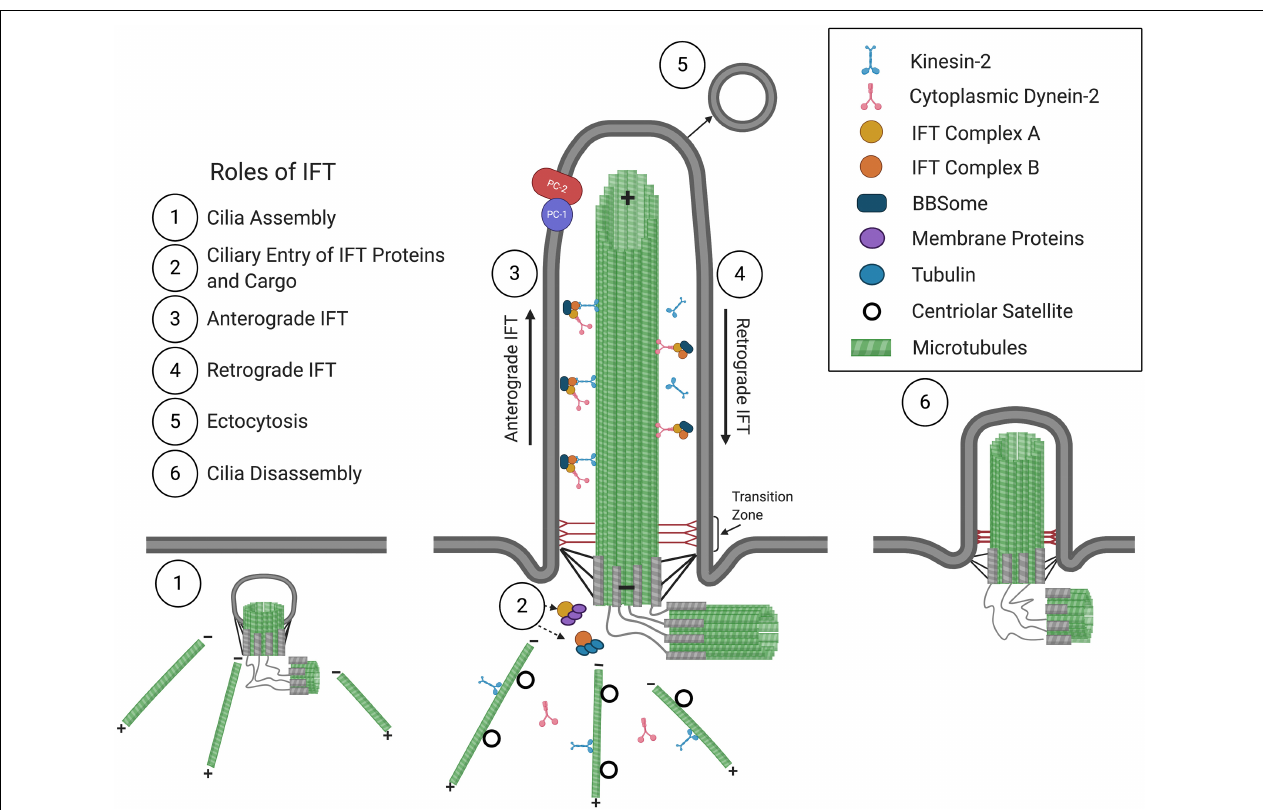
FIGURE 1 | The primary cilium and roles of IFT in cilium assembly/disassembly. Consisting of a 9 + 0 arrangement of a microtubular axoneme ensheathed by a specialized ciliary membrane, the primary cilium assembles initially within the cytoplasm at the modified centriole (1), which becomes the basal body that forms the base of the primary cilium at the plasma membrane. Extension and maintenance of the cilium, along with the entry and exit of structural and functional components and the BBSome, are mediated by IFT (2–4). Roles for IFT in ectocytosis (5) and cilia disassembly (6) have also been implicated (see text for details). The positive (+) and negative (–) ends of axonemal and cytoplasmic microtubules are indicated. The polycystins, PC1 and PC2, are localized at the ciliary membrane and are mutated in